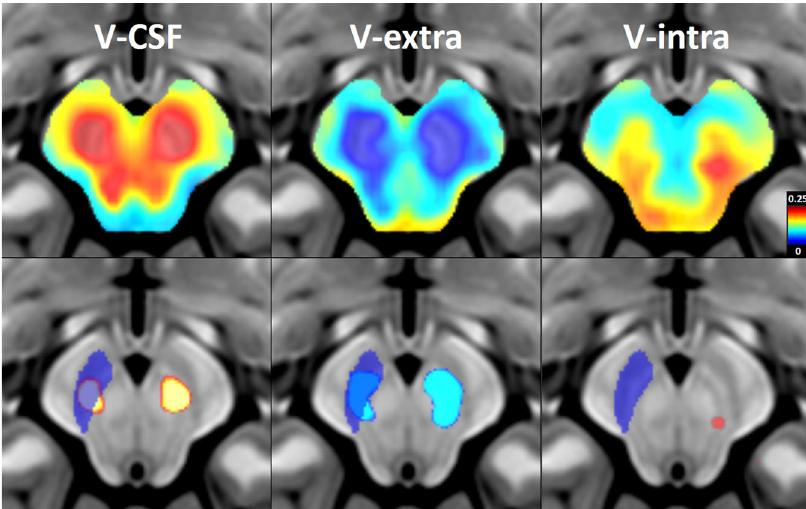
Fig. 1 Voxel-wise group comparison of nigral microstructure between patients with PD and healthy controls. Voxel-wise group comparison of DMI parameters between patients with PD ( n = 108) and healthy controls ( n = 35) superimposed on a T1w MRI template in standard space. The analysis controlled for age and sex, and a 5% false discovery rate (FDR) was applied. Top row: Standardized regression coef fi cients were extracted from regression models in PD and HC groups (with the covariates “ age ” and “ sex ” ). Color-coding indicates coef fi cient values as a measure of effect size of the factor “ Parkinson ’ s disease ” on DMI-parameters (hot colors: positive effect size vs. cold colors: negative effect size). Bottom row: Signi fi cant results of the voxel-wise group comparisons with a 5% FDR. The right SN is shown in blue. The left side of the image corresponds to right side of the patient ’ s body. DMI diffusion microstructure imaging, SN substantia nigra, FDR false discovery rate, V-CSF compartment of free interstitial fl uid, V-extra compartment of somata and unmyelinated axons, V-intra intra-axonal and dendritic